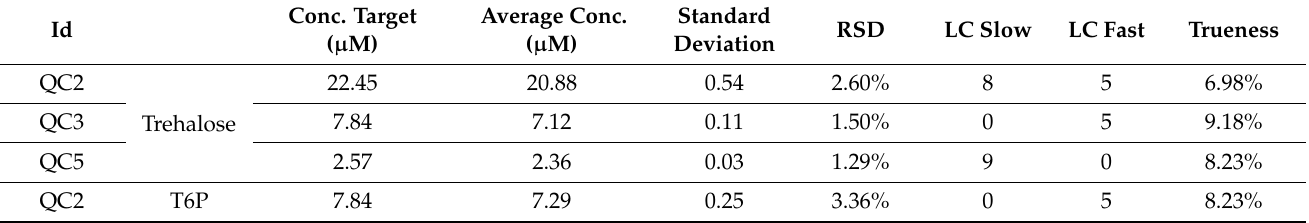
Table 3. Intra-day assay precision and trueness data for trehalose (3 levels) for 2 LC conditions